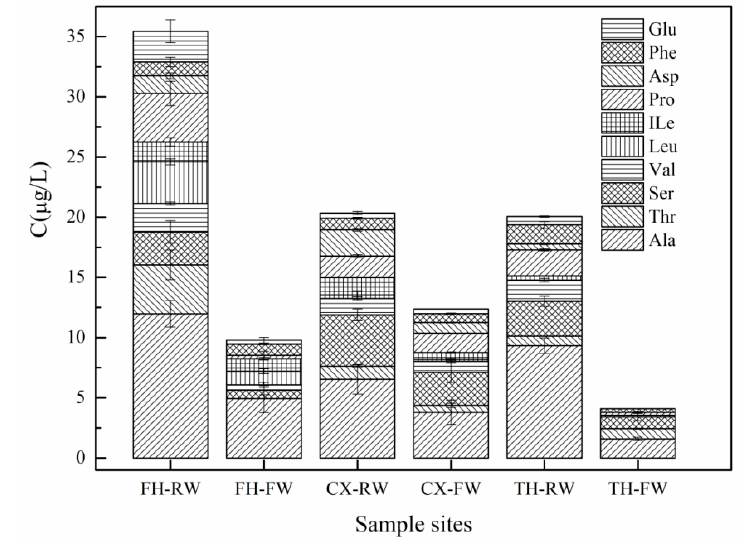
Figure 3. Annual average concentration of total FAAs in FH wastewater plant and CX and TH waterworks.